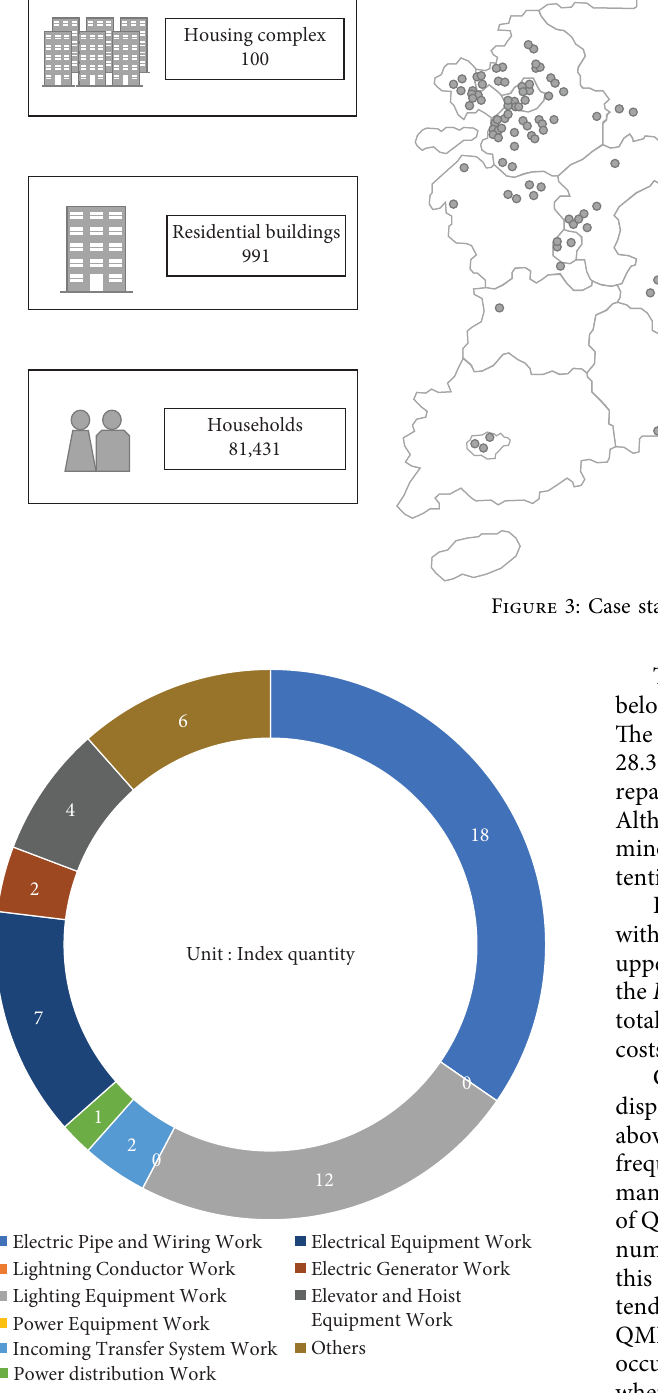
Figure 4: Distribution on detailed